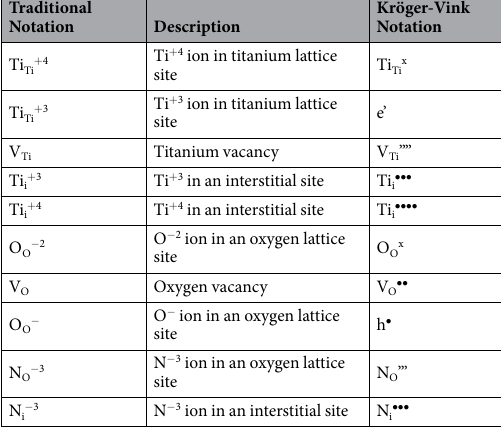
Table 2. Traditional and Kröger-Vink notations of defects in TiO 2 and N-doped TiO 2